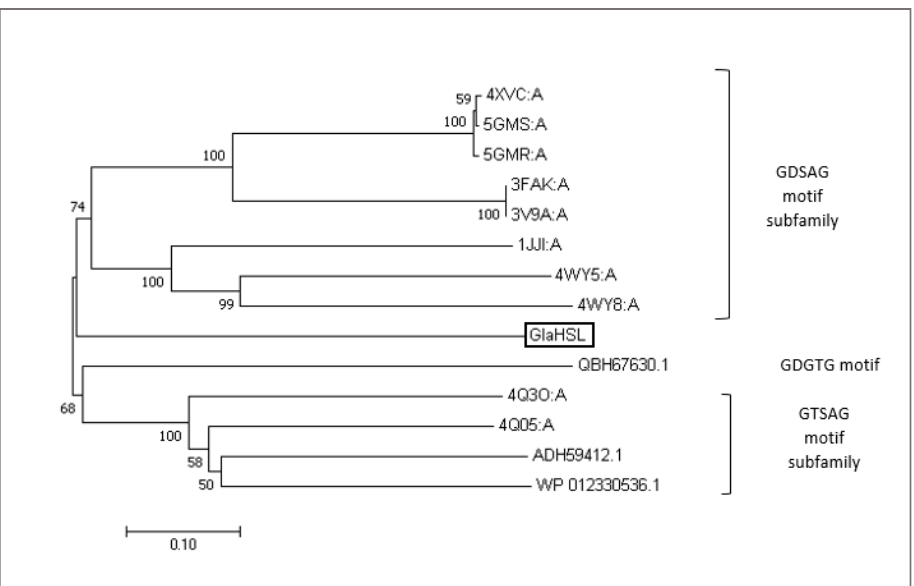
Figure 2. Phylogenetic tree of representative esterase sequences from microbial hormone-sensitive lipase (HSL) family generated using MEGA 7.0. The amino acid sequences were retrieved from the National Centre of Biotechnology (NCBI) and Research Collaboratory for Structural Bioinformatics Protein Data Bank (RCSB PDB) database. The neighbour-joining method was built with a Jones-Taylor-Thornton matrix-based model to estimate the phylogenetic tree. The black box indicates GlaEst12.